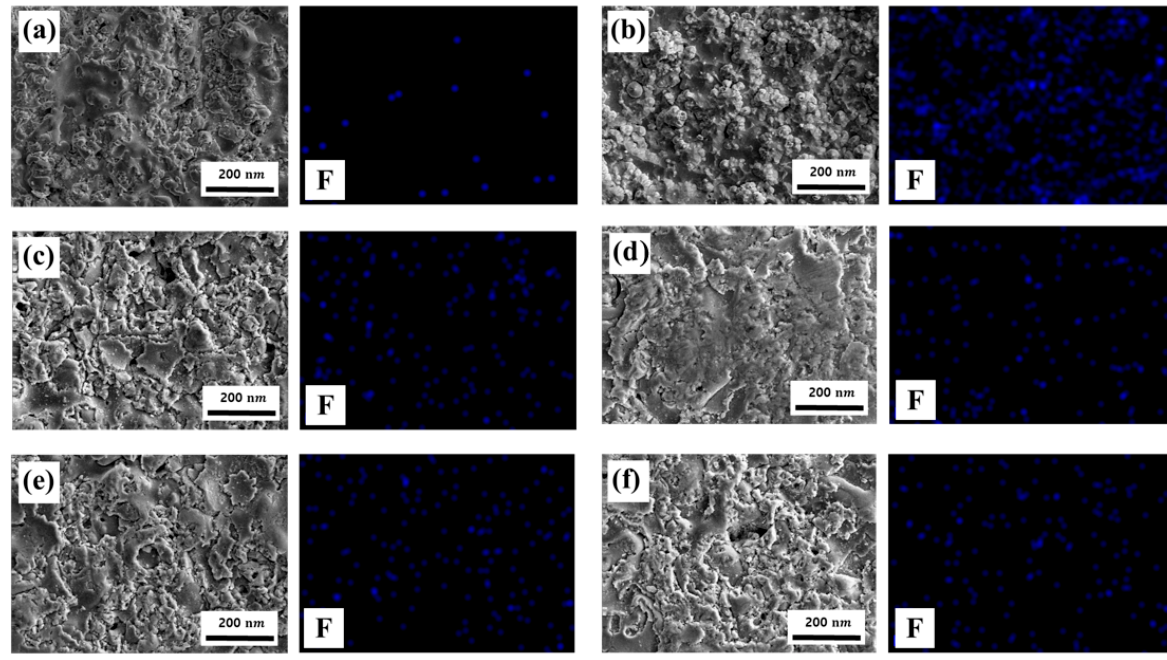
Figure 6. EDS mapping (fluorine “F”) images of the surface of APS–Y 2 O 3 coatings: ( a ) pristine APS–Y 2 O 3 , ( b ) APS–Y 2 O 3 plasma exposure and after cleaning with piranha solutions prepared at ratios of ( c ) 2:1, ( d ) 3:1, ( e ) 4:1, and ( f ) 5:1.